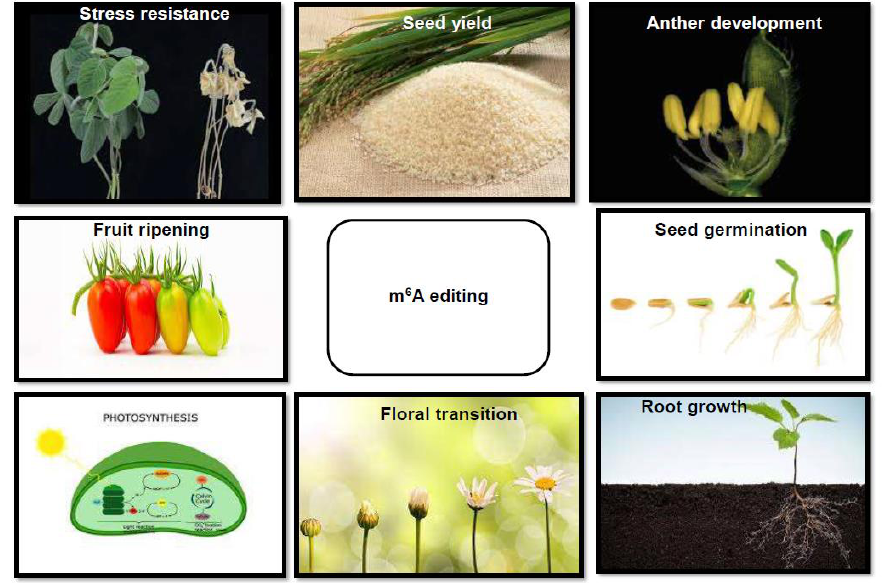
Figure 4. Improving useful traits through m 6 A editing; Various plant developmental processes such as seed development, anther development, root growth, floral transition, photosynthesis, fruit ripening, seed yield, and stress resistance can be improved through m 6 A